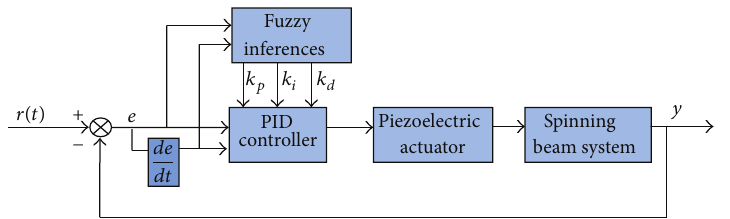
Figure 3: The fuzzy self-tuning PID controller for spinning beam structure.